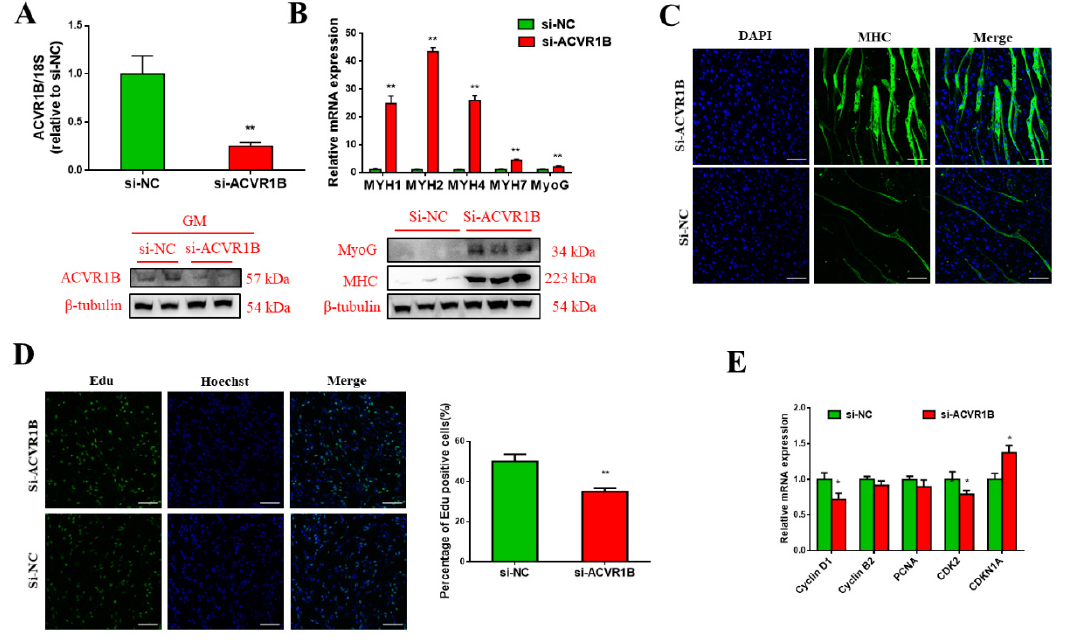
Figure 5. ACVR1B knockdown promotes myogenic di ff erentiation, but inhibits proliferation. ( A ) The transcript and protein levels of ACVR1B in PDGFR α - progenitor cells transfected with si- ACVR1B or si-NC. ( B ) The transcript and protein levels of MHC and MyoG on D5 of di ff erentiation in bovine PDGFR α - progenitor cells transfected with si- ACVR1B or si-NC. ( C ) MHC-positive cells on D5 of myogenic di ff erentiation in PDGFR α - progenitor cells transfected with si- ACVR1B and si-NC, as visualized by immunofluorescence. ( D ) EdU staining assay of PDGFR α - progenitor cells transfected with si- ACVR1B or si-NC, and the determination of EdU-positive cells. ( E ) Relative transcript levels of cell cycle-related genes in PDGFR α - progenitor cells transfected with si- ACVR1B or si-NC. Scale bars = 100 µ m. All data are represented as mean ± standard deviation (SD), based on at least three independent experiments for each treatment. * p < 0.05 and ** p <